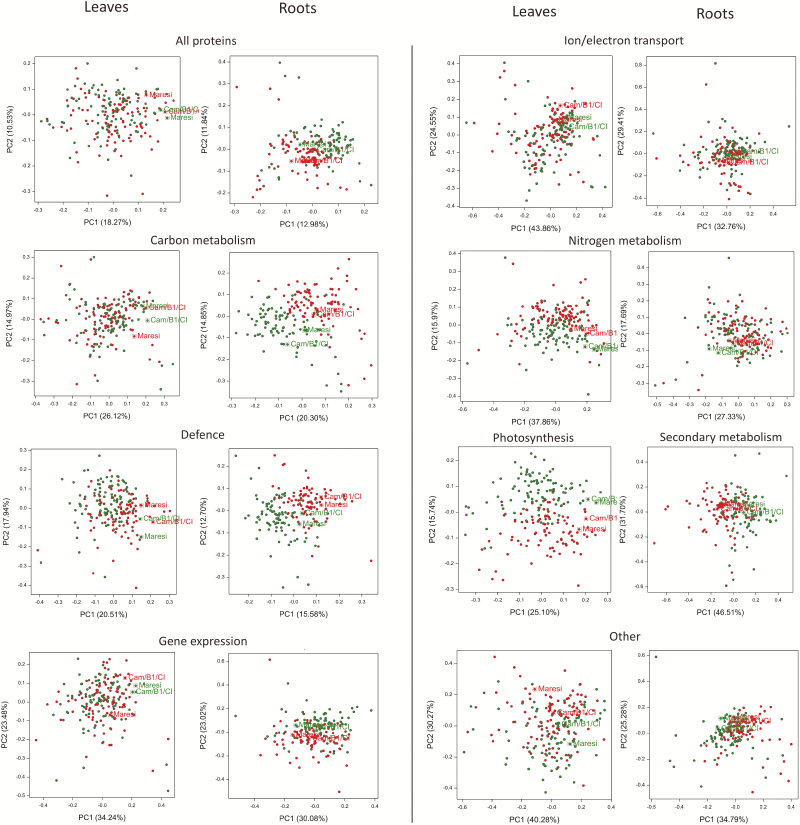
Principal coordinate analysis of RILs and parental genotypes for all observed proteins and proteins in functional groups. Green circles, control samples; red circles, drought samples; circles in squares mark parental forms.